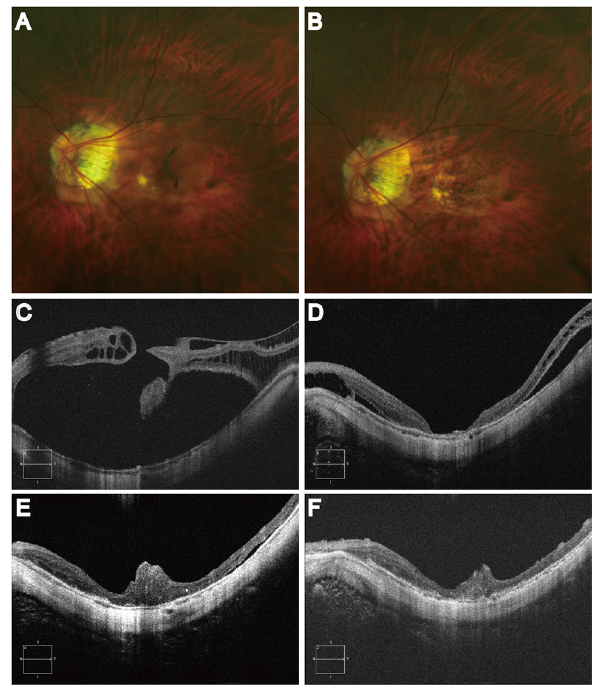
Figure 3. Representative images of persistent submacular fluid and post-operative glial hyper-proliferation. Fundus color photos ( A – B ) and OCT images ( C – F ) of a patient in inverted multi-layer ILM flap group before and after operation. MHRD in the left eye ( A ) and retinal reattachment at 3 months after operation ( B ); OCT images showed macular retinal detachment, full-thickness macular hole and macular retinoschisis before surgery ( C ). Type 1 Macular hole closure was achieved at 1 month post-op and no proliferation was observed ( D ). Persistent submacular fluid absorbed gradully during post-op follow-up ( D , E , F ). Glial hyper-proliferation appeared at 3 months post-op ( E ) and remained stable at 6 months post-op ( F